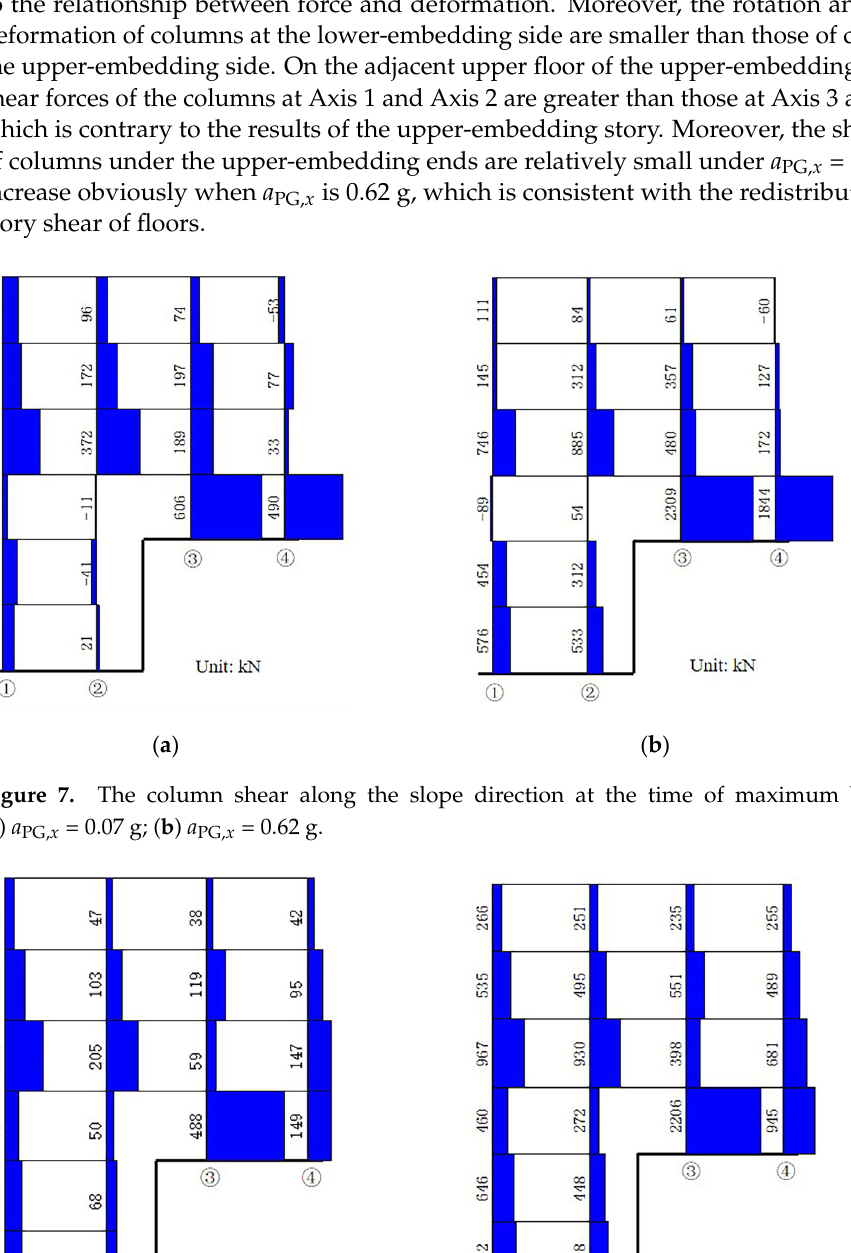
Figure 8. The column shear across the slope direction at the time of maximum base shear: ( a ) a PG, x = 0.07 g; ( b ) a PG, x = 0.62 g.